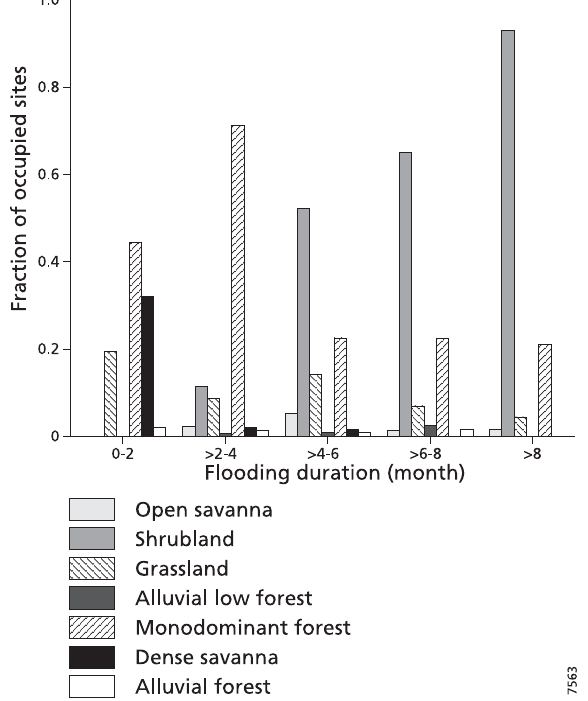
Fig. 10. Fraction of occupied sites by the seven identified communi- ties along the flood duration gradient. Flooding gradient is divided in five flood classes representing number of flooded